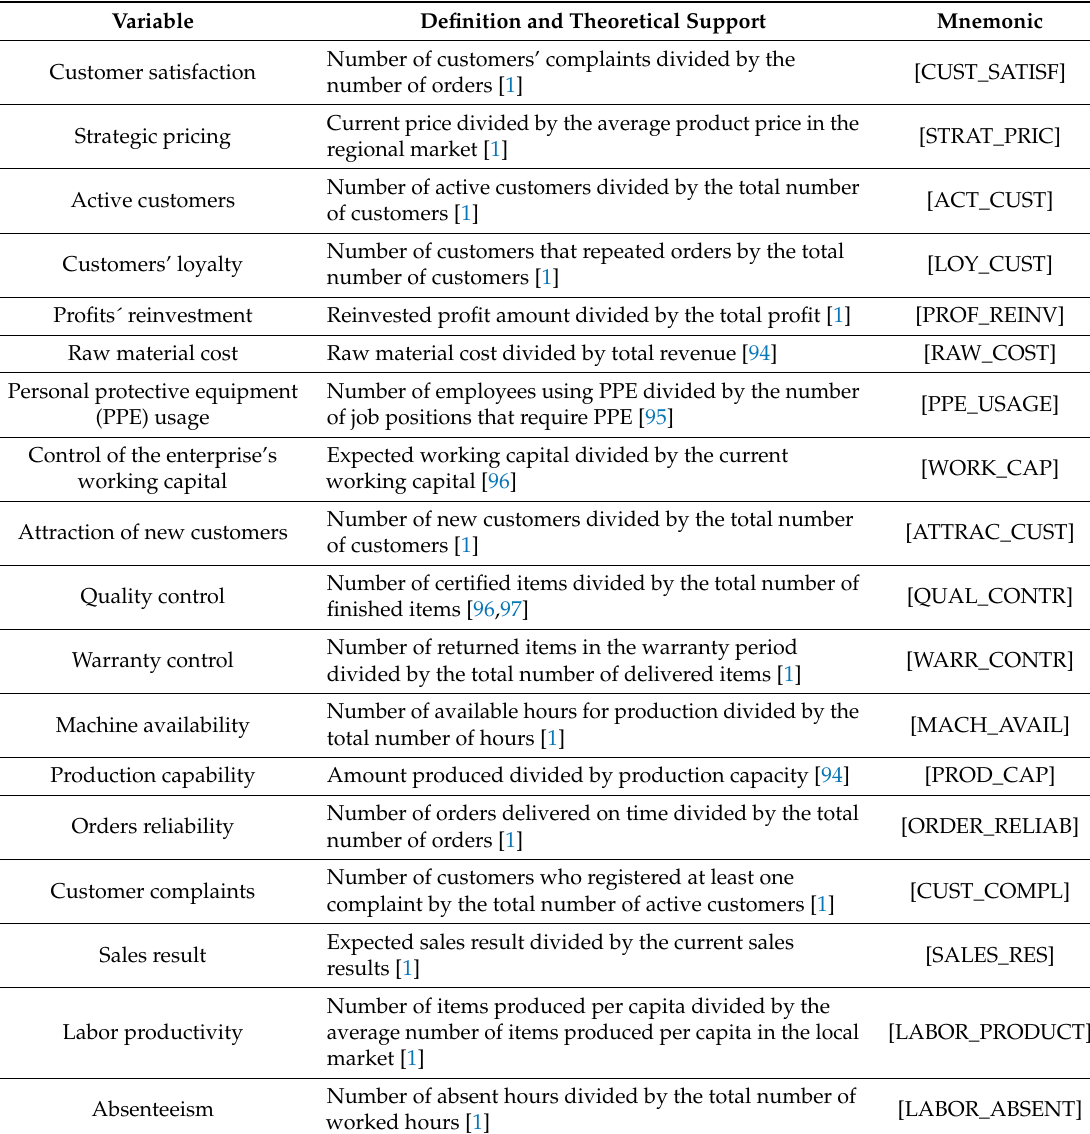
Table 2. Competitiveness